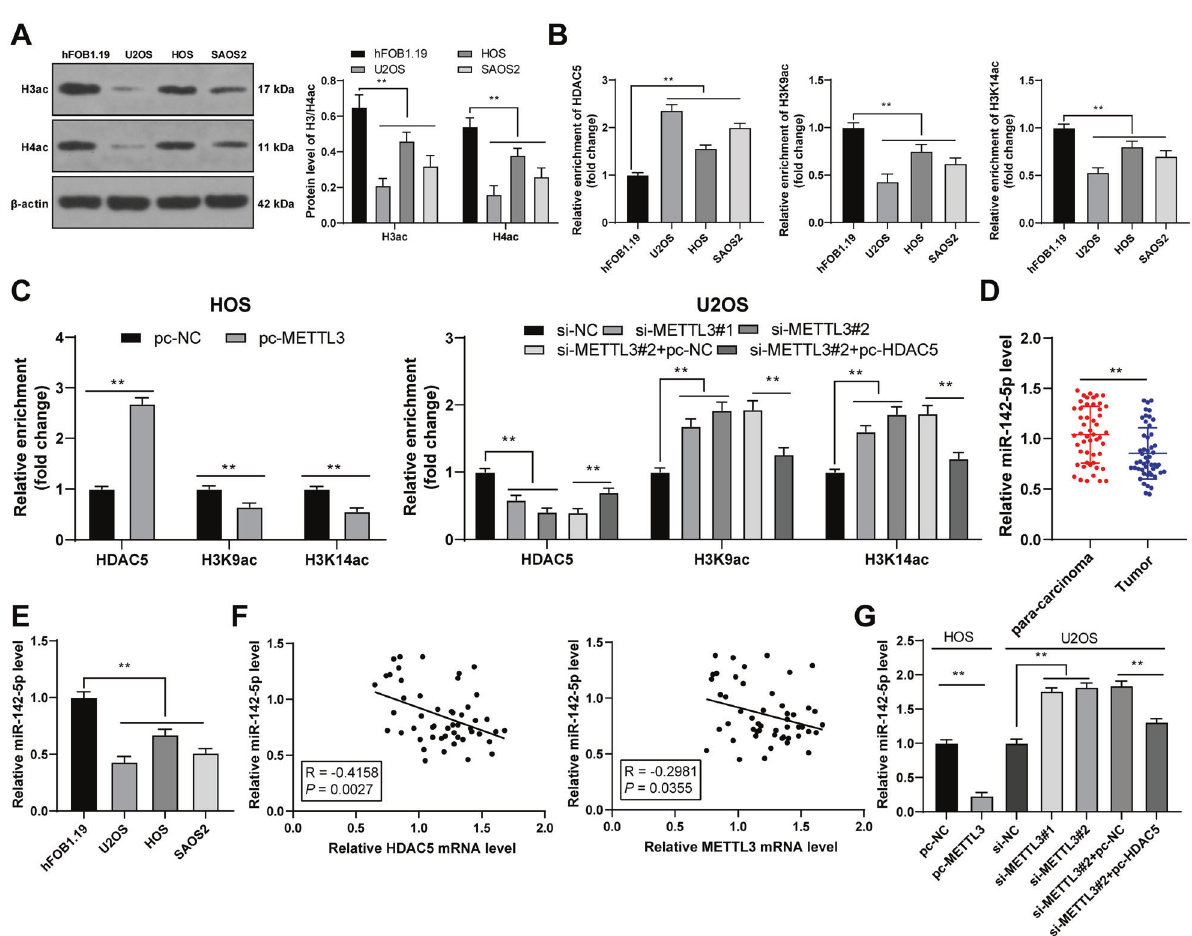
K14ac on miR-142 promoter in human OS cell lines (U2OS, HOS, SAOS2) and normal osteoblasts (hFOB1.1) was analyzed using ChIP-qPCR. D miR-142-5p expression in 50 pairs of OS tissues and adjacent tissues was determined using RT-qPCR. E miR-142-5p expression in human OS cell lines (U2OS, HOS, SAOS2) and normal osteoblasts (hFOB1.1) was determined using RT-qPCR. F The correlation between miR-142-5p and HDAC5 and METTL3 in OS tissues was analyzed using Pearson correlation analysis. G miR-142-5p expression in OS cells after intervention with METTL3 and HDAC5 expression was measured using RT-qPCR. N = 50. The cell experiment was repeated three times independently. Data in panels A – C / E / G are presented as mean ± standard deviation. Data in panel D were analyzed using paired t -test. Data in panels B / E / G were analyzed using one-way ANOVA, and data in panels A/C were analyzed using two-way ANOVA, followed by Tukey ’ s multiple comparisons test, * p < 0.05, ** p <